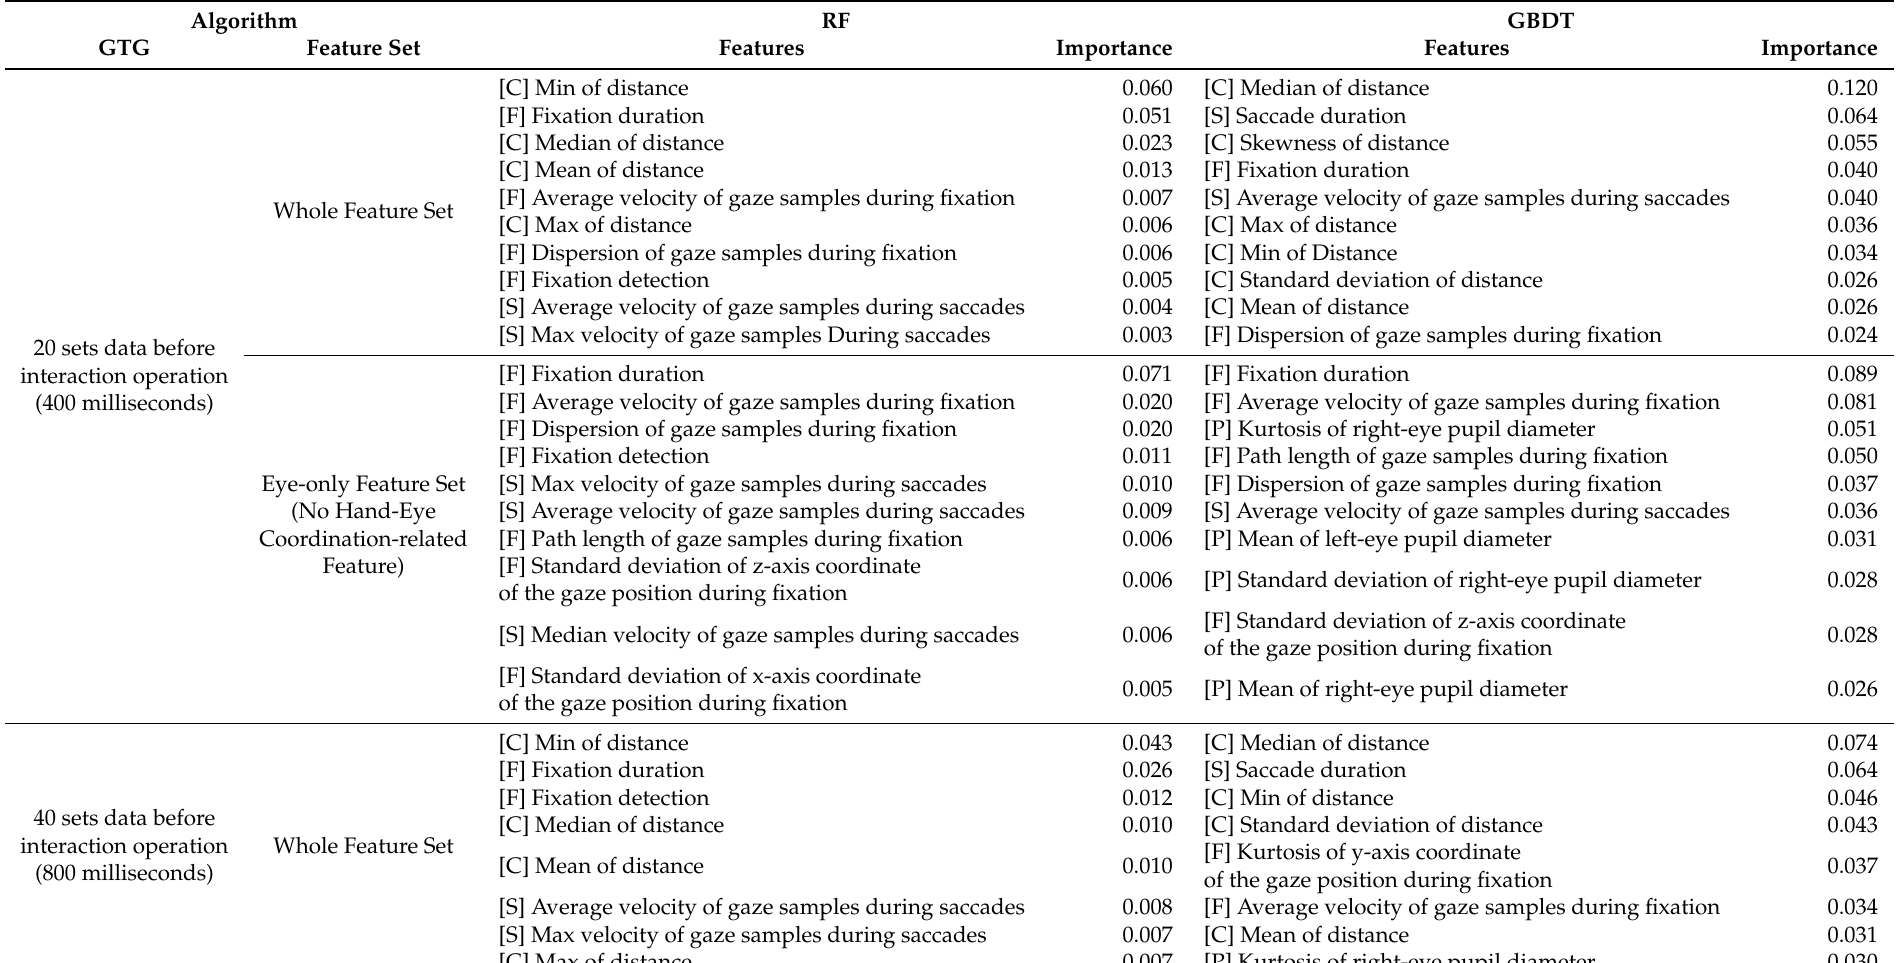
Table 4. Top-ten importance features based on RF and GBDT feature importance scores of binary